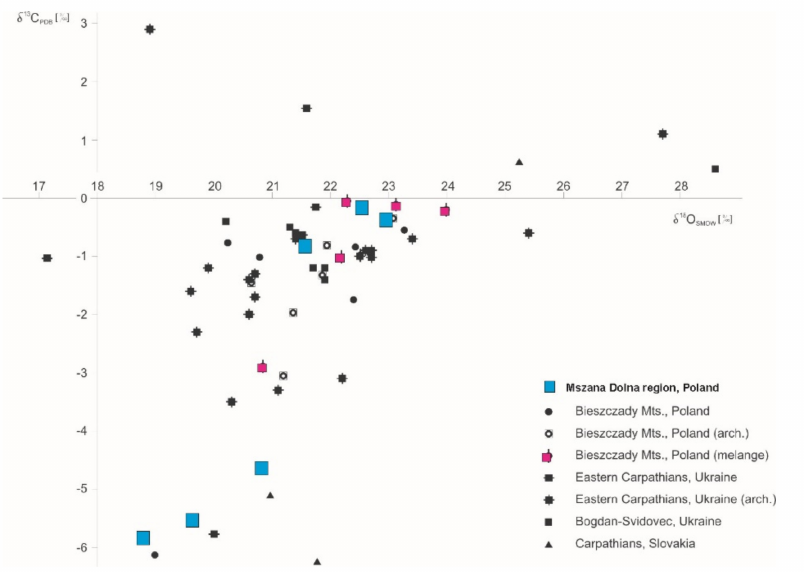
Figure 6. Stable isotope results in the Mszana Dolna area and the Jabłonki-Rabe-Cisna region on the background of data for other parts of the Carpathians (the background after